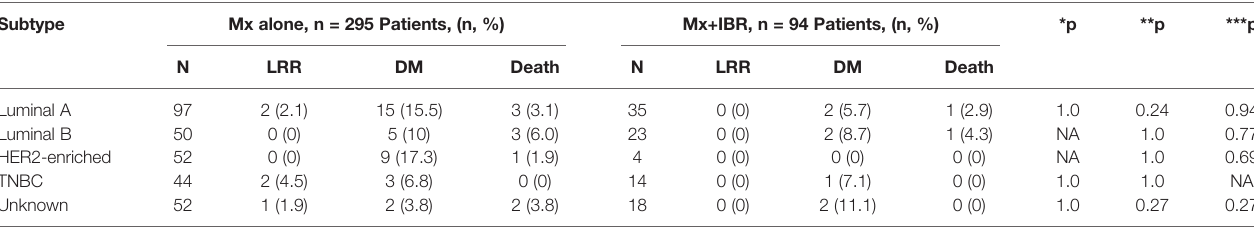
TABLE 4 | Locoregional recurrence and/or distant metastasis of breast cancer by molecular subtype. Subtype Mx alone, n = 295 Patients, (n, %) Mx+IBR, n = 94 Patients, (n, %) *p N LRR DM Luminal